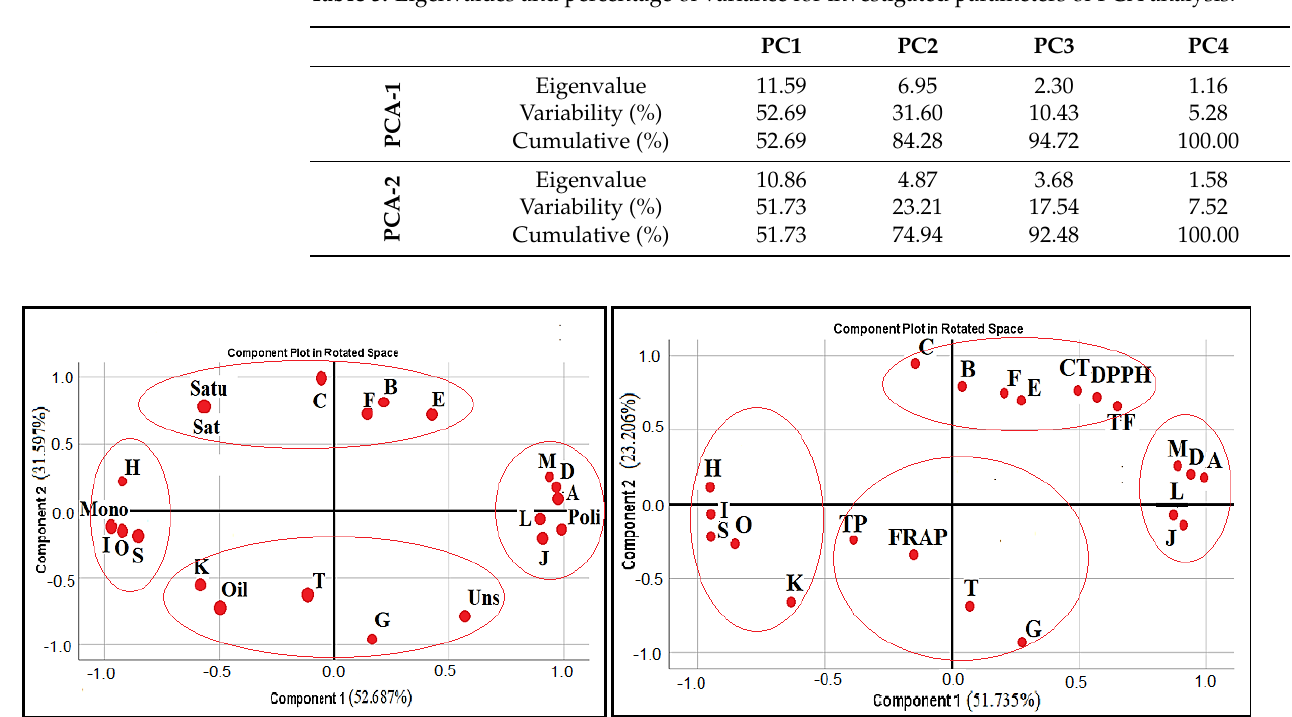
Table 5. Eigenvalues and percentage of variance for investigated parameters of PCA analysis.